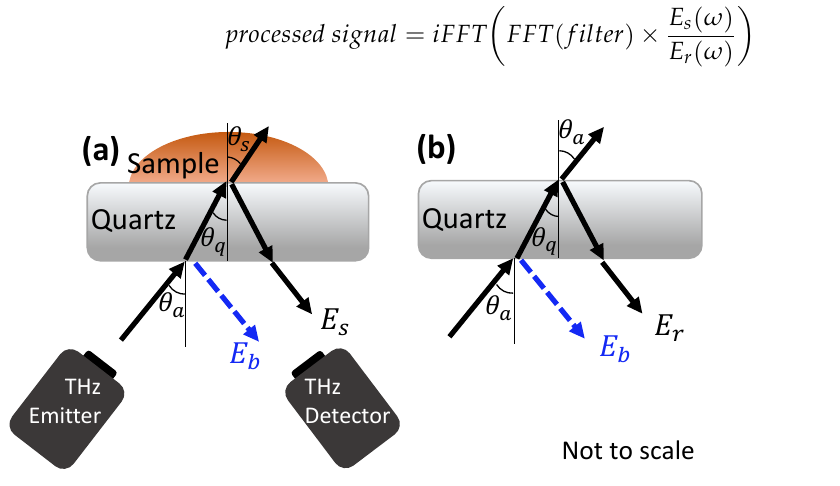
Figure 3. The reflection of an incident THz pulse from the quartz imaging window when the sample, 𝐸 𝑠 ( a ) and reference, 𝐸 𝑟 ( b ) measurements are acquired. The baseline reflections, 𝐸 𝑏 , from the underside of the quartz imaging window are shown in blue.